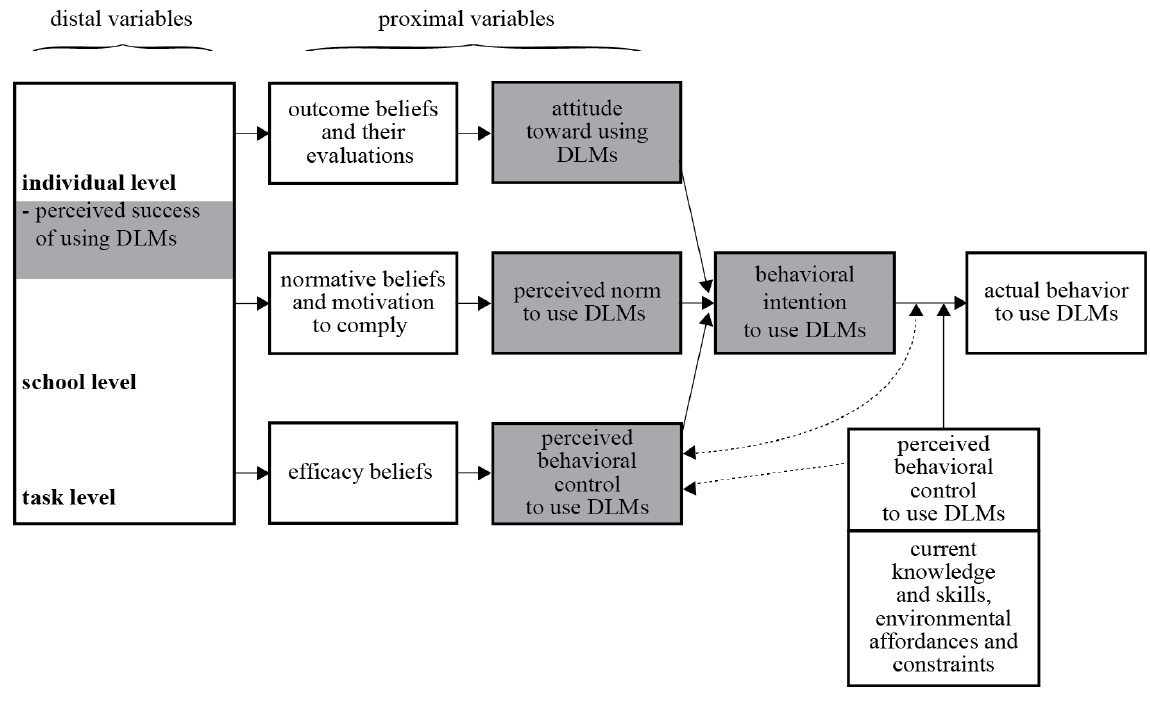
Figure 1. The Reasoned Action Approach applied to teachers’ use of